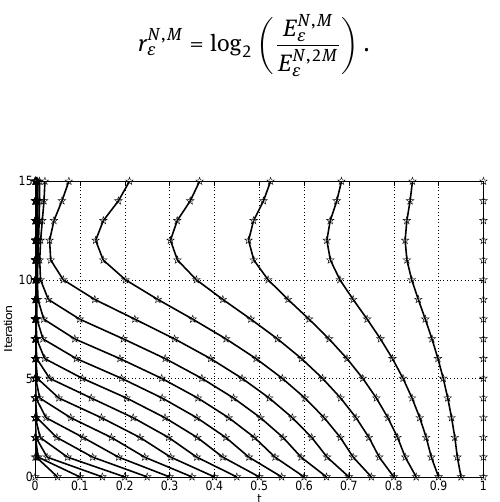
Figure 1: Mesh movement with ε = 10 −2 , x m = 0.5, N = 10 and